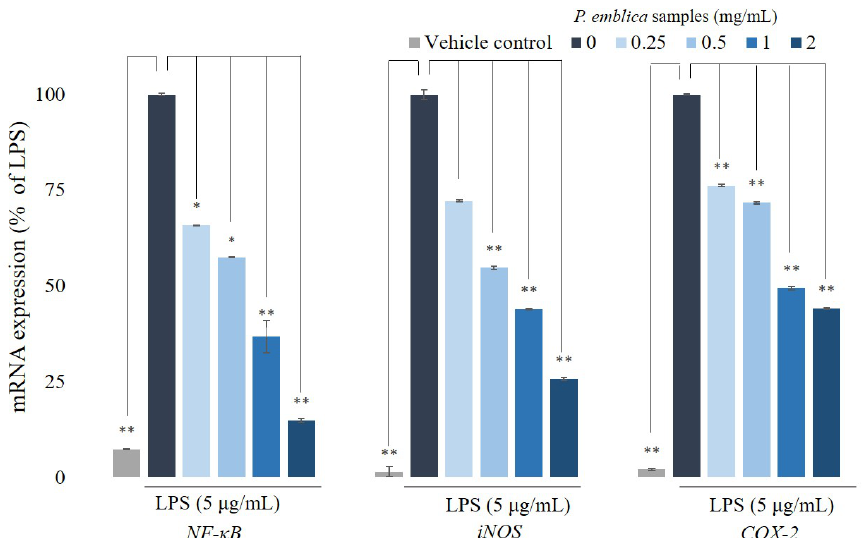
Figure 3. The inflammation-related mRNA expressions in RAW 264.7 cells. RNA expression levels of NF- κ B, iNOS, COX-2 in RAW 264.7 cells treated with different concentrations of P. emblica samples (0.25–2 mg/mL) were evaluated by qRT-PCR and normalized to the GAPDH gene. The data represented mean ± S.D of three independent experiments performed. *p < 0.05, **p < 0.01. Antioxidants 2019 , 8 , x FOR PEER REVIEW